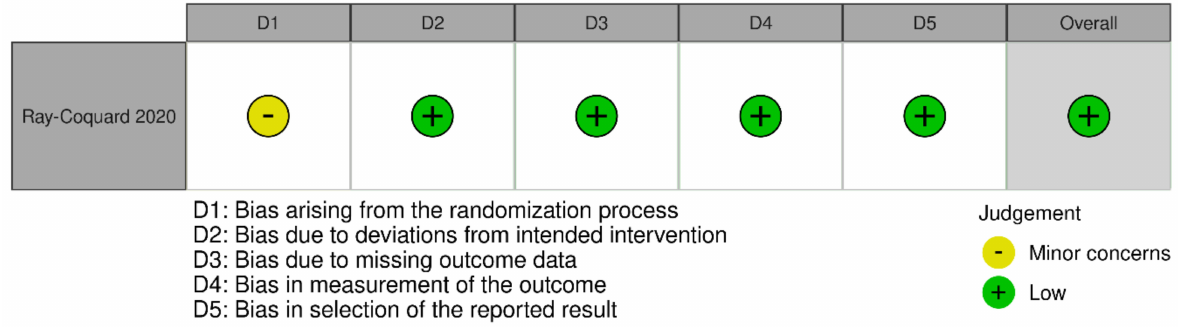
Figure A1. Risk of bias results in an RCT using the RoB2 tool [27].